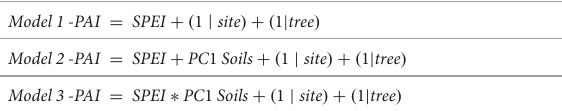
TABLE 1 The three linear mixed-models that were tested to describe the relationship between the variation in the tree growth (periodic annual increment – PAI), and the drought indices (Mean negative SPEI), soil fertility (PC1 axis of the soil data), and the random effect at each site and on each